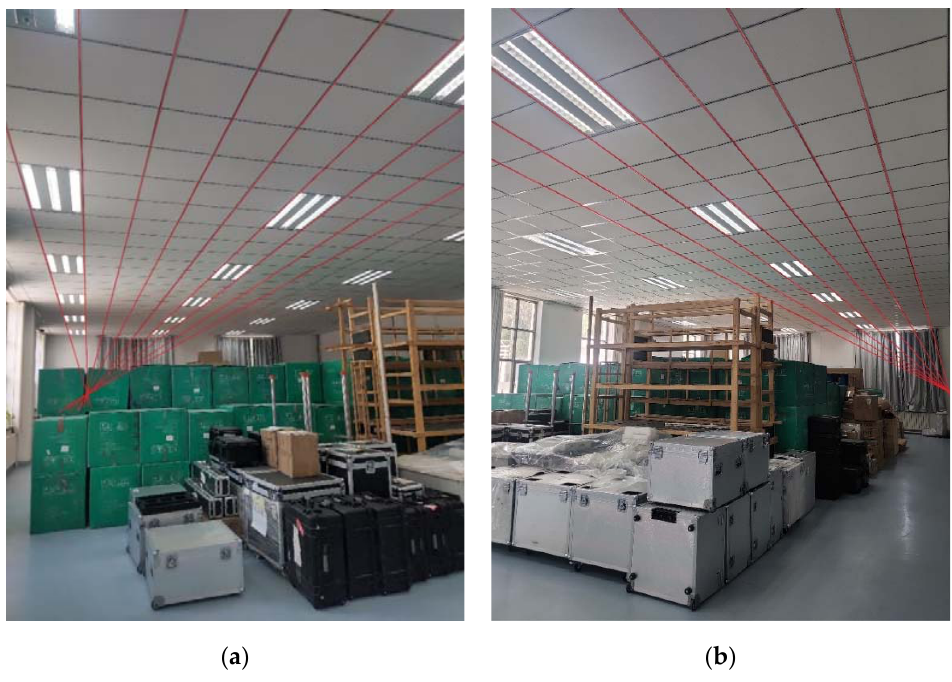
Figure 6. Real images and vanishing points: ( a ) left camera; ( b ) right camera.